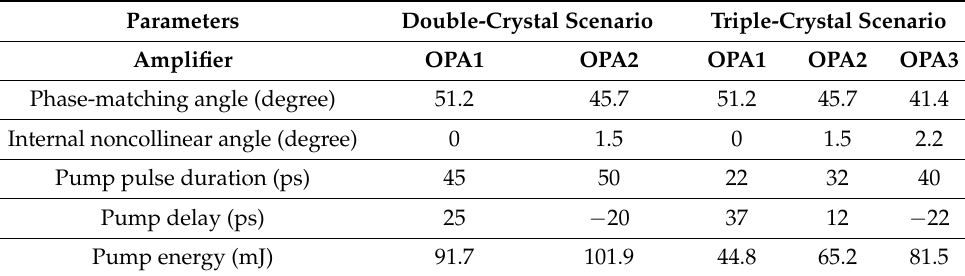
Figure 5. ( a ) The amplified spectrum and the spectral phase after dispersion compensation up to TOD for double-crystal scenario, ( b ) the temporal profiles of signal before and after the high order dispersion compensation, the temporal distributions of the signal along X axis ( c ) before and ( d ) after the compensation of the high order dispersion. For the triple-crystal scenario, the evolution of the signal and pumps in the temporal domain are shown in Figure 6a–c. The thickness of the OPAs here is same as the double- crystal scenario. The output signal energies are 47.7 mJ, 88.9 mJ, and 140.3 mJ after each OPA. The effective efficiency of this amplification stage reaches 62.8%. The residual tem- poral distributions of the pump along X axis for the three OPAs are shown in Figure 6d– f, respectively.